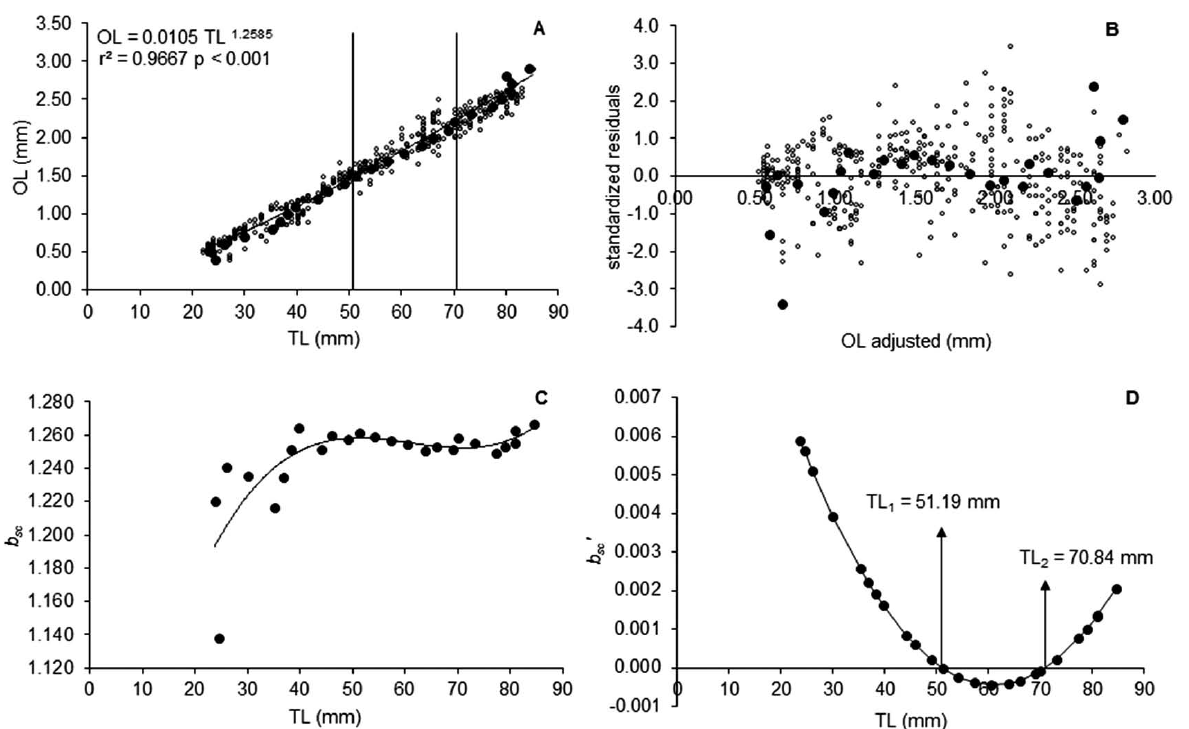
Fig. 4. – A, power regression between total length (TL) and otolith length (OL) of Anchoa tricolor of the Paranaguá Estuarine Complex (Paraná State, Brazil) (open circle = individual measurements; filled circle = average values for 0.1 mm OL class. B, standardized residuals adjusted from power regression. C, exponential coefficient ( b ) for each total length (line = polynomial function). D, first derivative of sc polynomial function showing the stanza changing points of total length (TL and TL 1 2